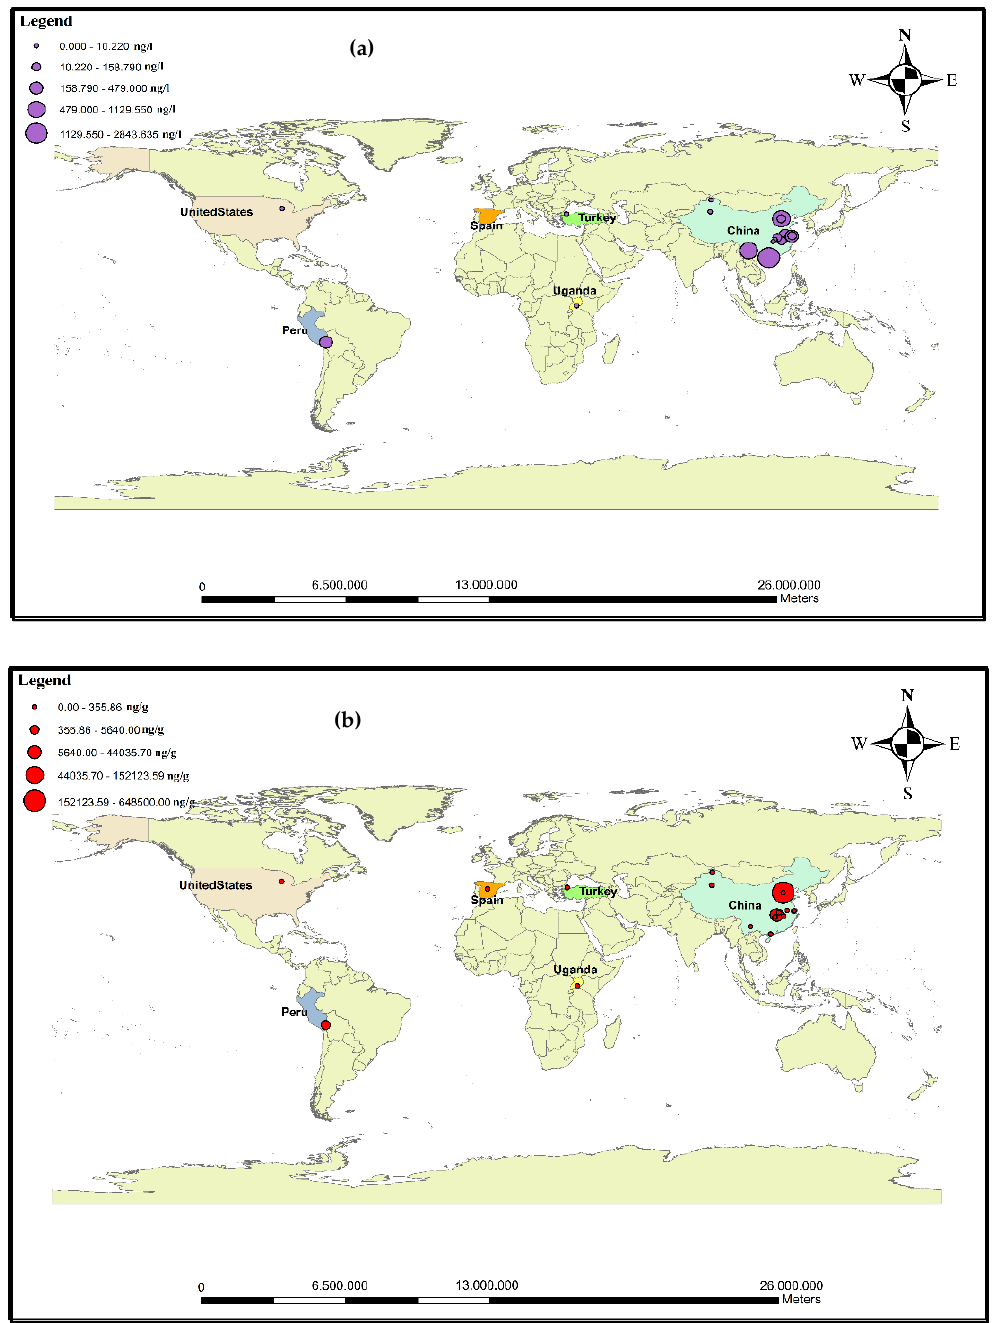
Figure 5. Map of studied areas for antibiotic contamination in ( a ) water and ( b ) sediments of lakes around the world.